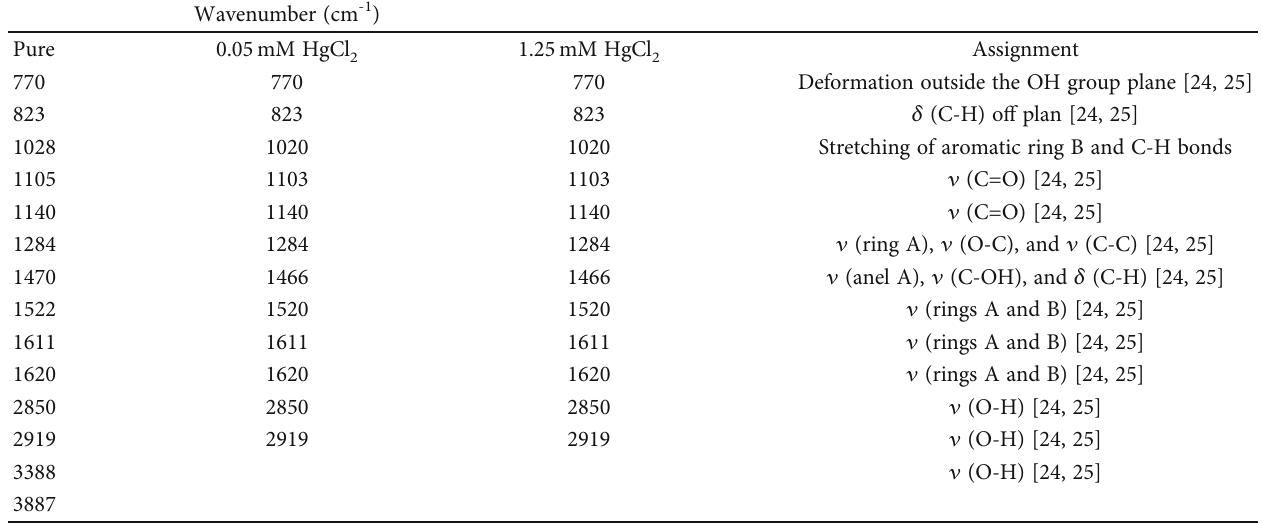
Table 1: Characterization of the most relevant FTIR peaks of pure catechin and associated with mercury chloride. Wavenumber (cm -1 )